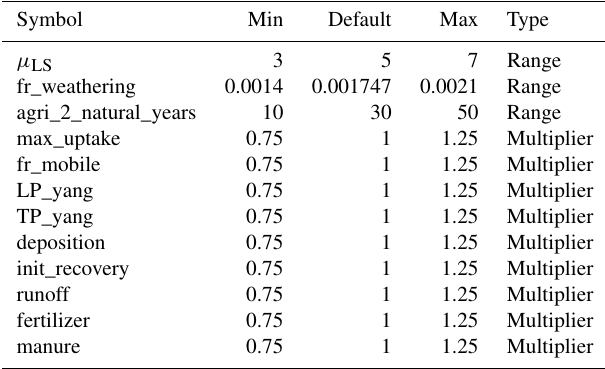
Table 3. The parameters included in the sensitivity analysis. Symbol